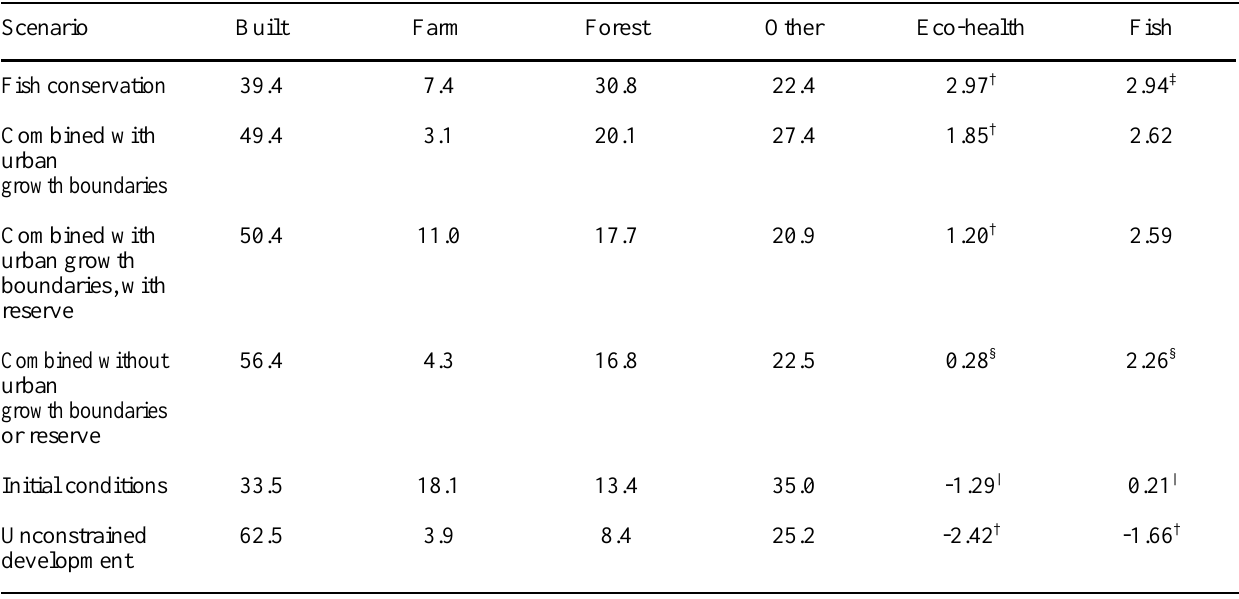
Table 4 . Comparison fish conservation, unconstrained development, and combined conservation and development scenarios. The combined scenario shows inclusion of UGBs, both UGBs and agricultural and forest reserves, and without UGBs or agricultural and forest reserves. Reported scores are averages of multiple